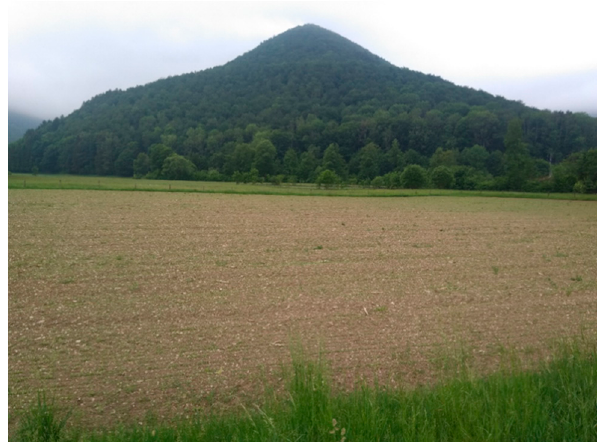
Figure 10. Witness mountain “Runder Berg”. From laypeople often classified as “typical volcano” (Author 2020).